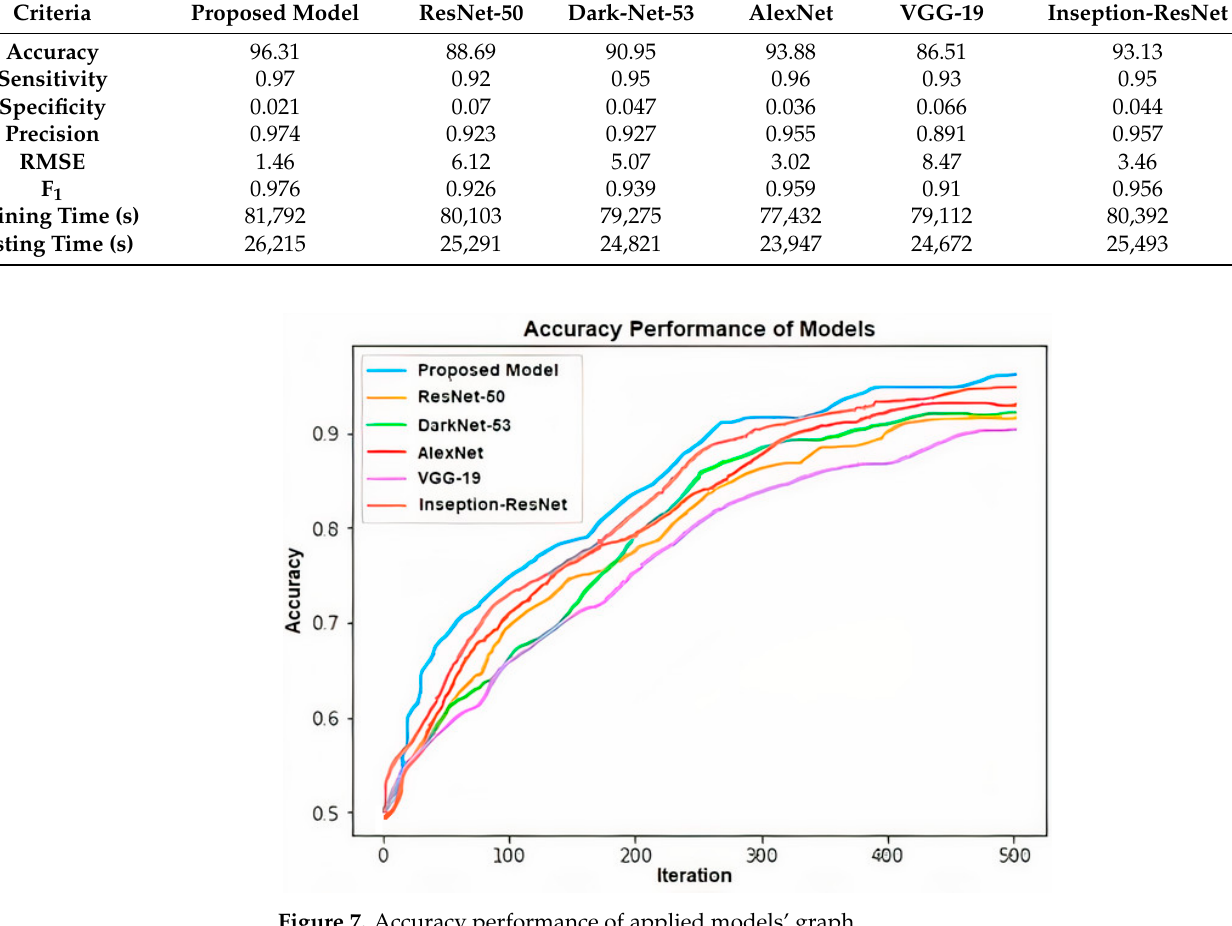
Figure 7. Accuracy performance of applied models’ graph.